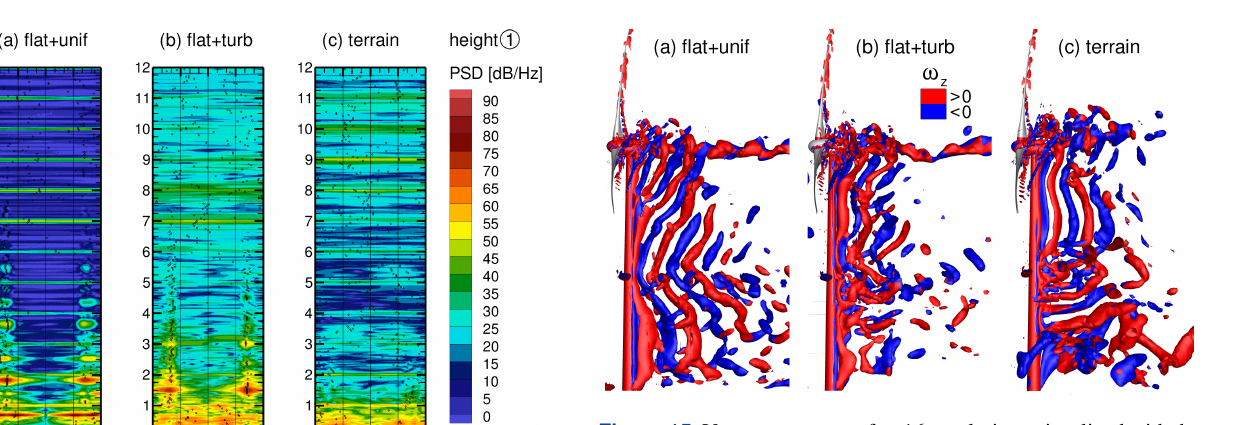
Figure 15. Vortex structures after 16 revolutions visualized with the λ 2 criterion and coloured with vertical vorticity ω z for all cases (a) – (c) .